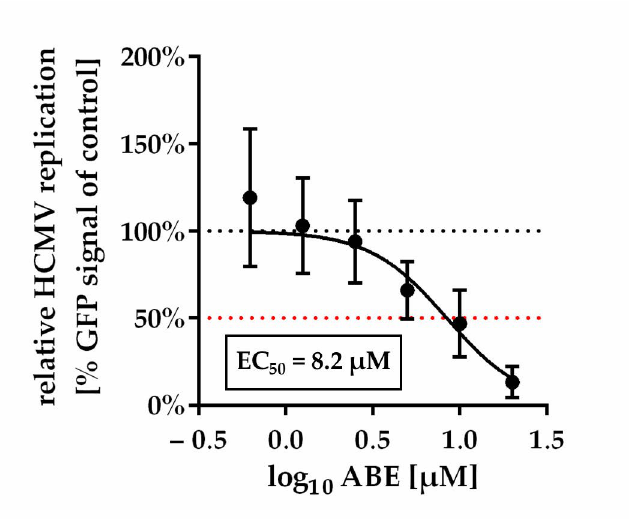
Figure 1. Dose-response curve of ABE against HCMV in vitro. Data are presented as mean relative HCMV replication compared to control ± SD over three independent experiments each consisting of biological duplicates.